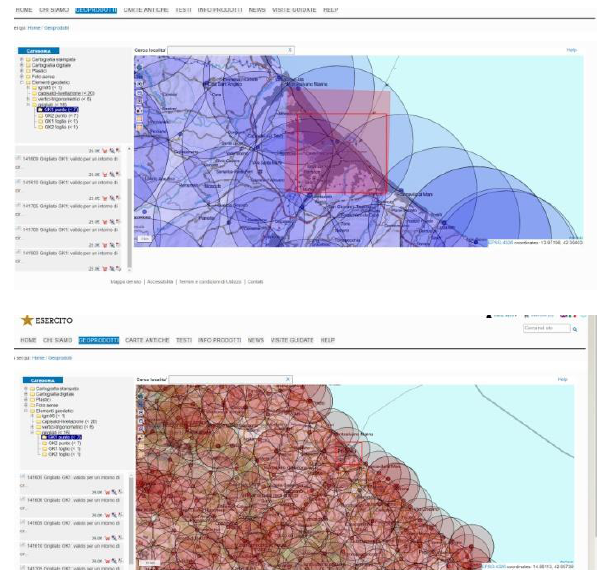
Figure 7: military Geographic Institute Date.